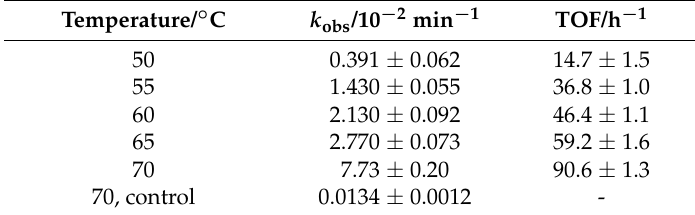
Table 2. Values of k obs and TOF for 2a synthesis catalyzed by Fe5F at different temperatures a . Temperature/ ◦